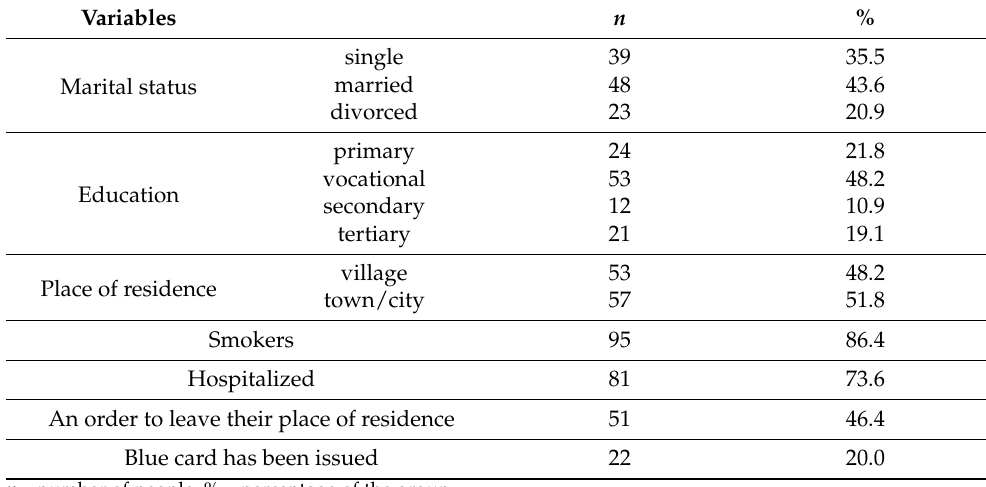
Table 1. Characteristics of the study group.